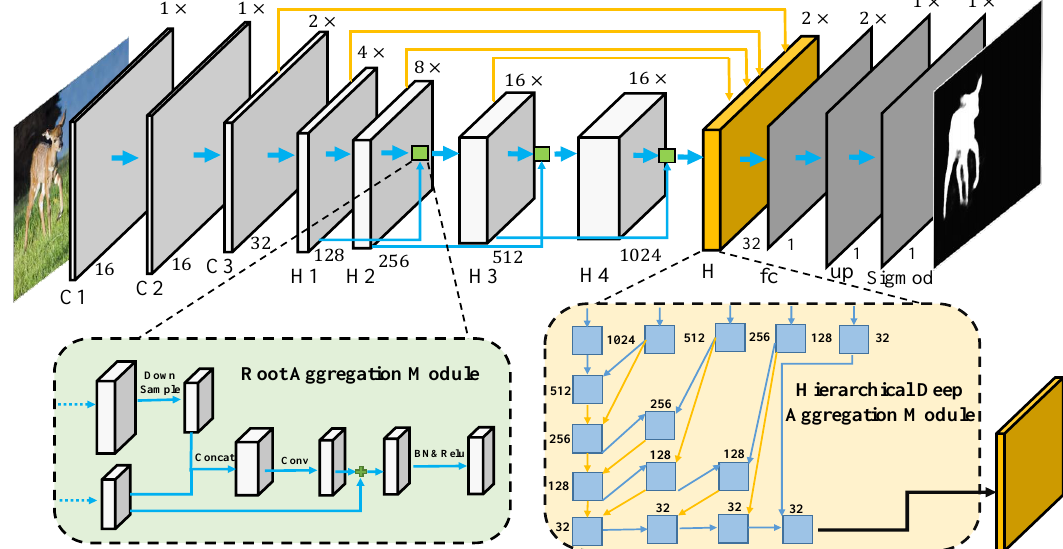
Figure 4. Illustrations of the proposed network architecture. In the hierarchical deep aggregation module, the orange lines indicate deconvolutional operators, and the blue blocks consist of convolution/BN/ReLU